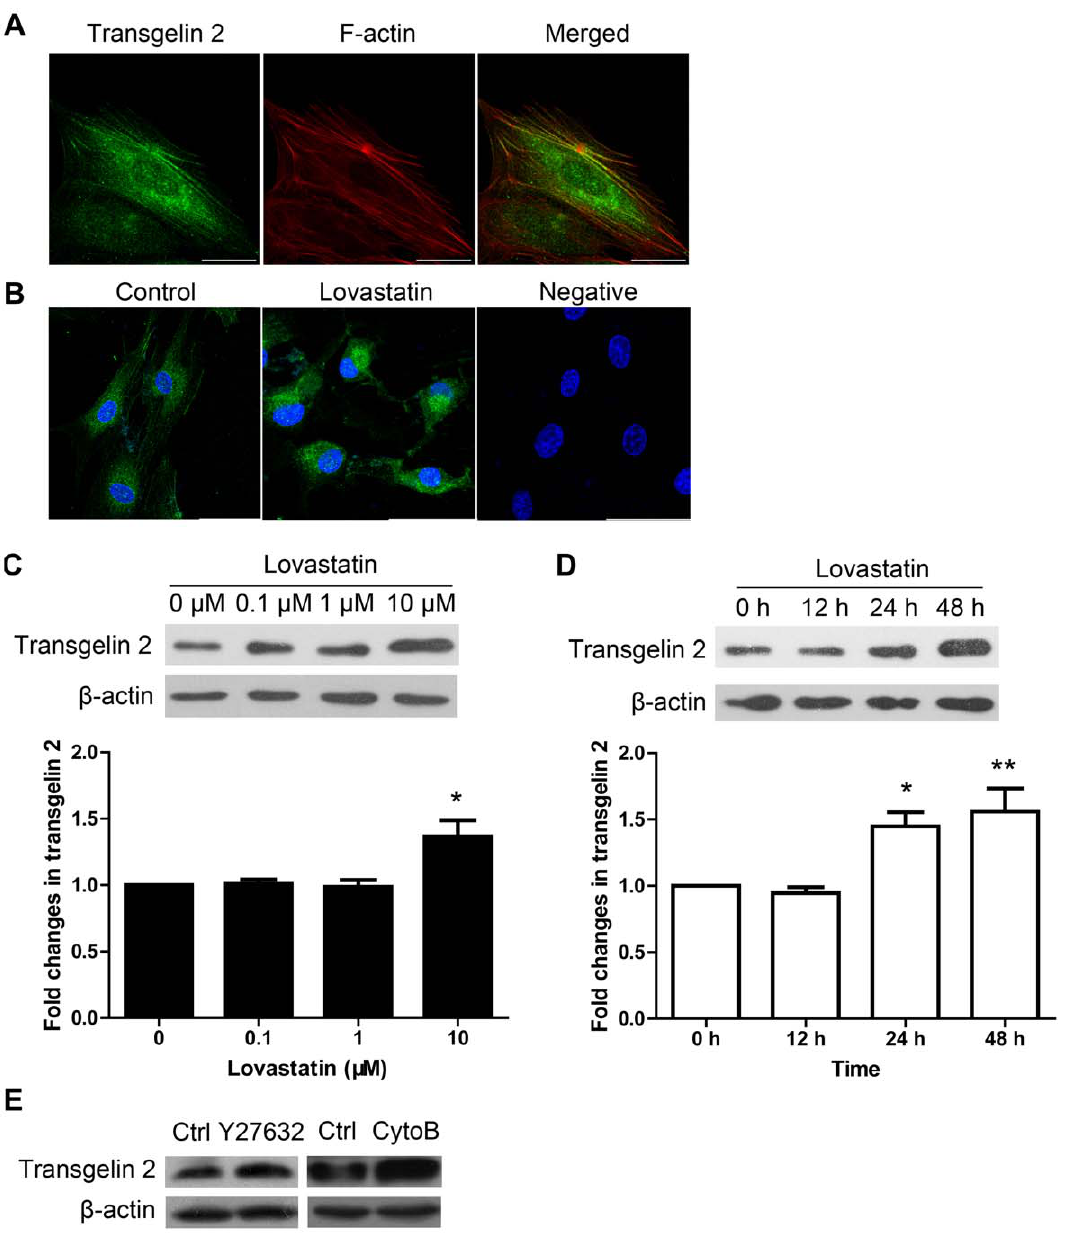
Figure 3. Lovastatin increases transgelin 2 expression. (A) The localization of transgelin 2 in HUVECs. Confocal microscopic examination showed the association (yellow) of transgelin 2 (green) with actin filaments (red). (B) The localization of transgelin 2 (green) in HUVECs after lovastatin treatment (10 m M, 24 h) was visualized under confocal microscope (40 6 magnification). The negative control shows a confocal image without primary antibodies. Hoechst was used for nuclei staining (blue). Scale bar: 50 m m. (C) Western blot analysis of HUVECs treated with the indicated doses of lovastatin for 24 h. Bands were quantitated by densitometry and normalized against b -actin (n=3). (D) Western blot analysis of HUVECs treated with lovastatin (10 m M) for the indicated times. Bands were quantitated by densitometry and normalized against b -actin (n=4). Each data point represents mean 6 SEM. *, p , 0.05; **, p , 0.01 compared with unstimulated control. (E) Transgelin 2 expression tended to be increased by the ROCK inhibitor Y-27632 (20 m M, 24 h) and the actin polymerization inhibitor cytochalasin B (cytoB, 5 m M, 24 h) compared to control